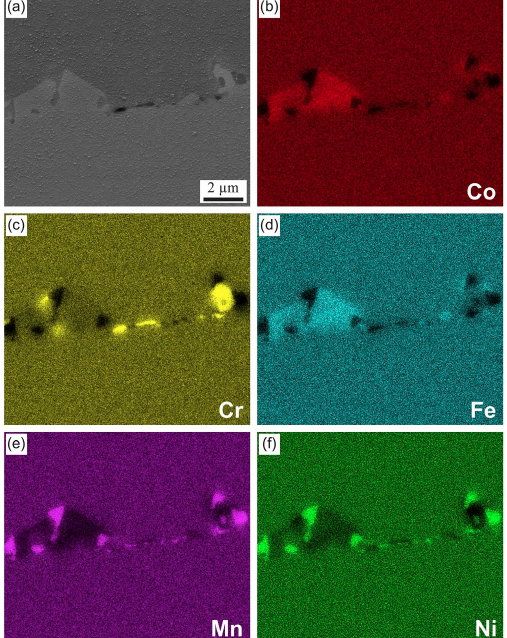
Figure 2. Microstructure of the CrMnFeCoNi HEA after a 500-day anneal at 500 °C. Representative BSE image showing multiple precipitates on a GB ( a ) and elemental EDX maps showing the distri- bution of Co ( b ), Cr ( c ), Fe ( d ), Mn ( e ) and Ni ( f ) in the area shown in ( a ). Reprinted with permission from Ref. [5]. Copyright 2016 Elsevier.